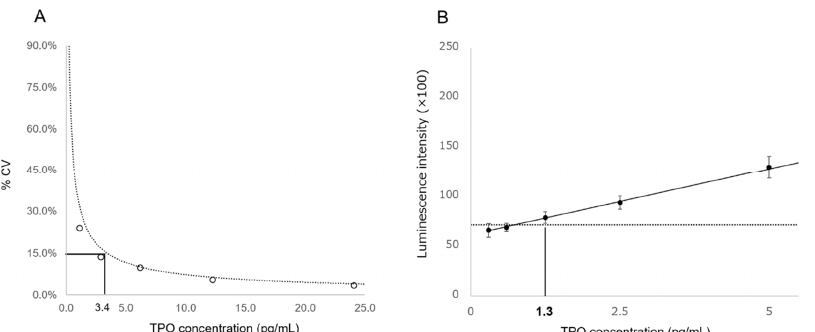
Figure 4. Results of plasma thrombopoietin functional sensitivity and analytical sensitivity studies. ( A ) The concentration, 3.4 pg/mL, was set as the lowest concentration that showed a total precision of 15% CV. ( B ) The concentration, 1.3 pg/mL, was set as the minimum value in the dilution panels where the mean + 2SD value on the low side did not exceed the mean-2SD value on the high side. CV, coefficient of variation; TPO, thrombopoietin. The recovery rates obtained after spiking rhTPO into three plasma samples are shown in Table 3. The percentage recovery ranged from 86.8% to 106.0%. Table 3. Recovery of TPO spiked into plasma samples.